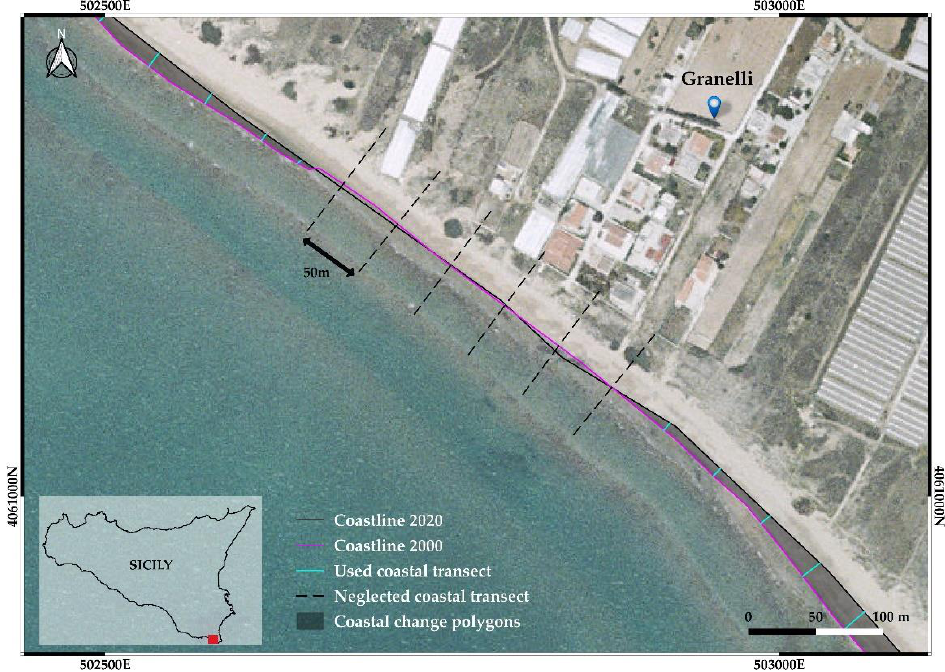
Figure 2. Example of coastal transect generation (Littoral Cells 5.1). Black dashed lines show the transects neglected in CeVI assessment, while cyan lines mark those used to assess CeVI indicators. The red box on the south of Sicily represents the study area. The background image is the orthophoto “Volo IT2000” related to the year 2000. (Reference System RS: WGS84 UTM33N—EPSG: 32633).